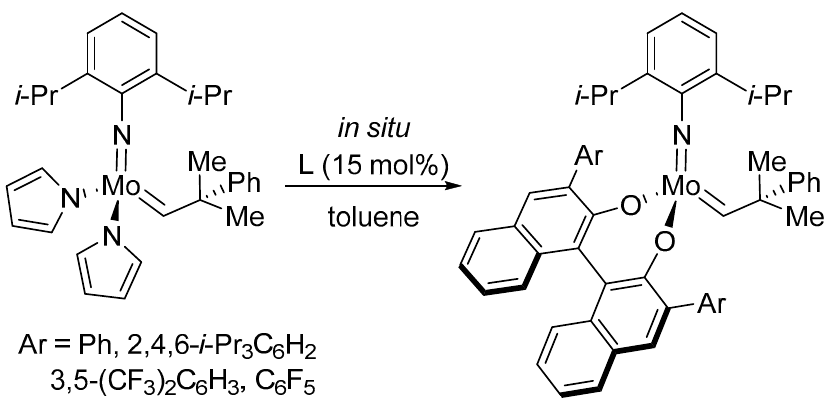
Figure 6. Commercially available chiral molybdenum alkylidene complexes tested in atroposelec- tive synthesis of binaphthalenes.